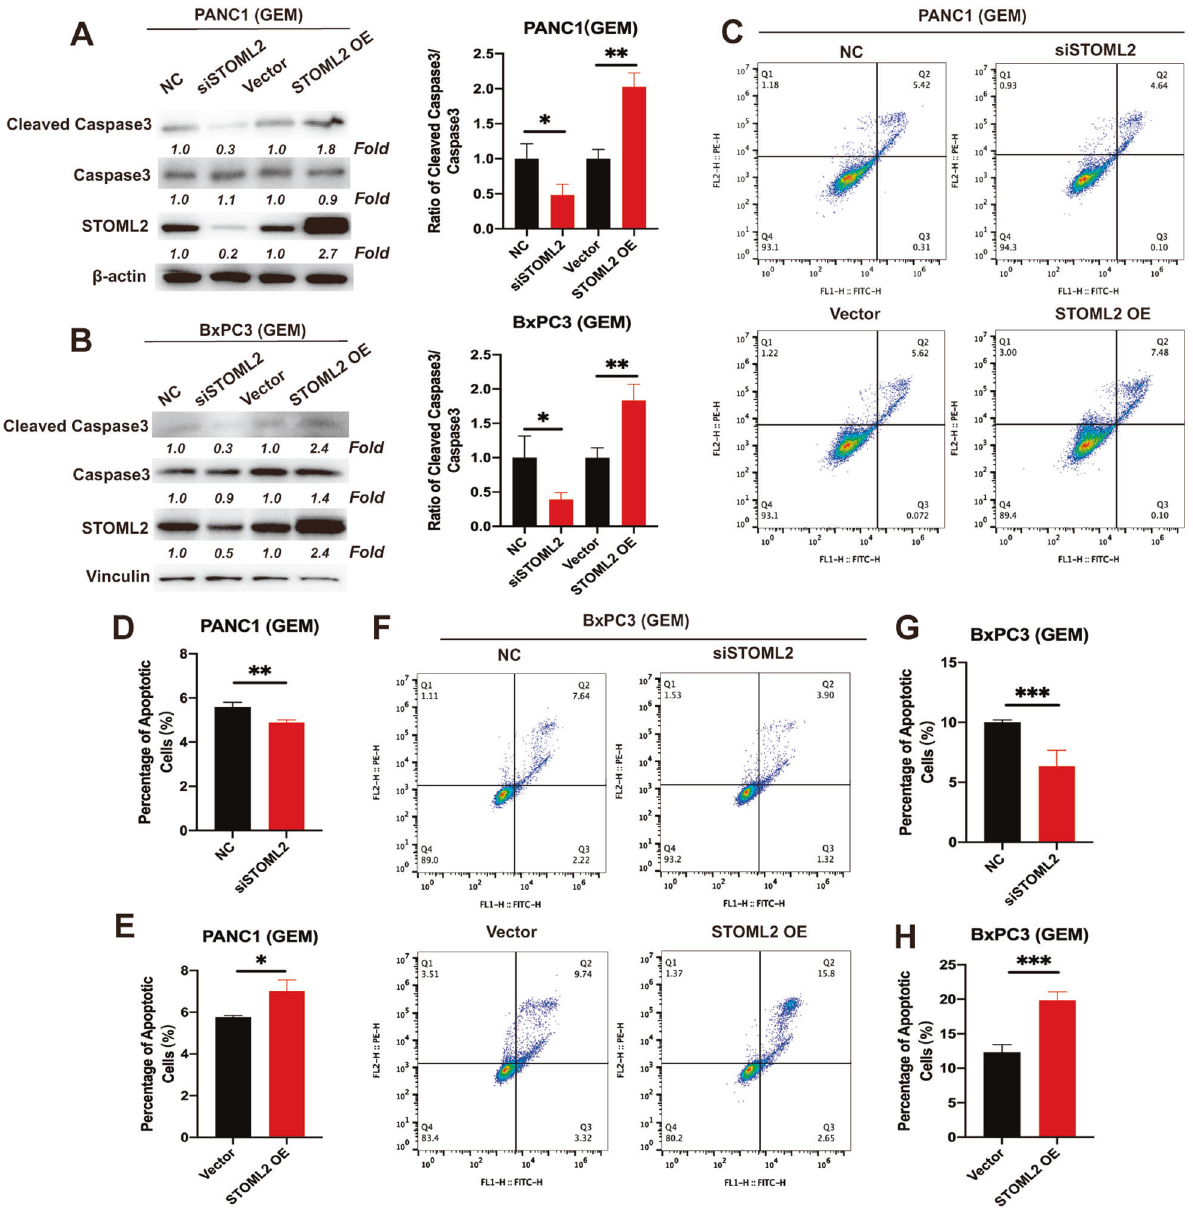
Fig. 5 STOML2 promoted GEM-induced apoptosis in pancreatic cancer cells. A , B Immunoblot showing the protein levels of cleaved caspase 3, caspase 3, STOML2, and Vinculin in PANC1 and BxPC3 cells after downregulating or upregulating STOML2, which were treated with GEM in cell medium for 24 h. C Dot plot from the fl ow cytometry staining to gate the apoptotic PANC1 cells after downregulating or upregulating STOML2, which were treated with GEM (10 μ M) in cell medium for 24 h. D , E The corresponding quantitative data of early and late apoptotic cells in PANC1. F Dot plot from the fl ow cytometry staining to gate the apoptotic BxPC3 cells after downregulating or upregulating STOML2, which were treated with GEM (1 μ M) for 24 h. G – H The corresponding quantitative data of early and late apoptotic BxPC3 cells. * P < 0.05; ** P < 0.01; *** P <